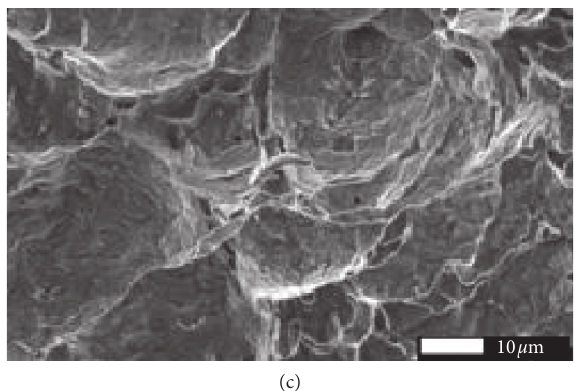
Figure 10: Fractograph of duplex stainless steel 2205 impact charpy “ V ” notch in TIG and ATIG in HAZ. (a) ATIG 1 heat affected zone